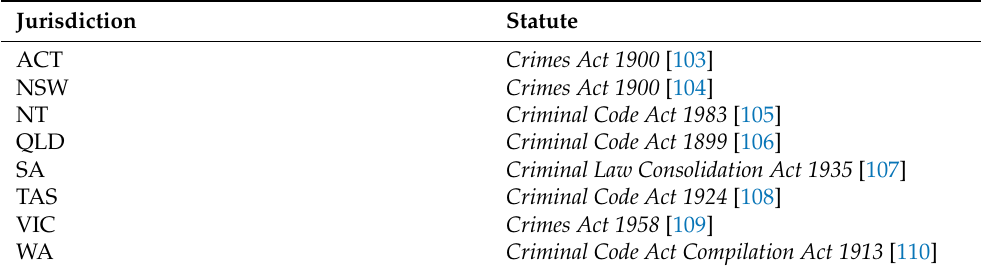
Table 9. Crime statutes per each Australian state and